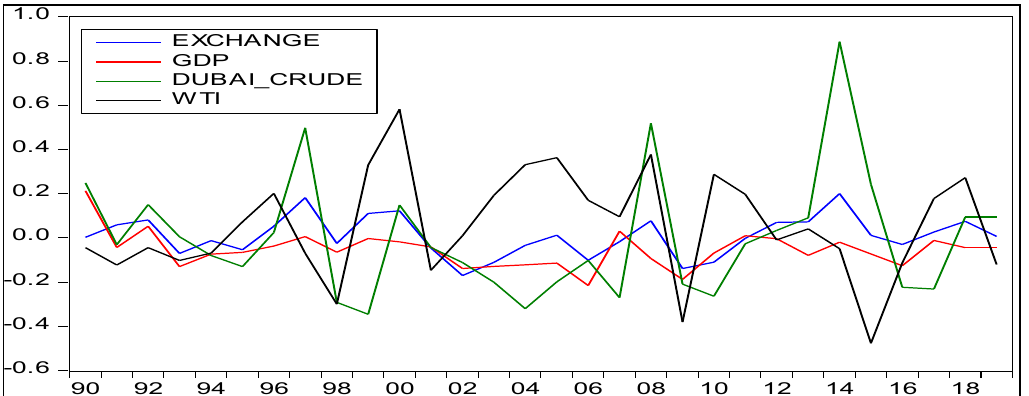
Figure 7. Graphical Expression for the Return Data of Exchange Rates of US dollar (US $)/Indian Rupee (INR), GDP per Capita and WTI Crude Oil Price in US dollar (US $) during 1990 to 2020; Sources: Compiled from https://www.imf.org/en/Data, https://databank.worldbank.org/home.aspx, and https://fred.stlouisfed.org/categoriesa, and computed using E. Views-10.